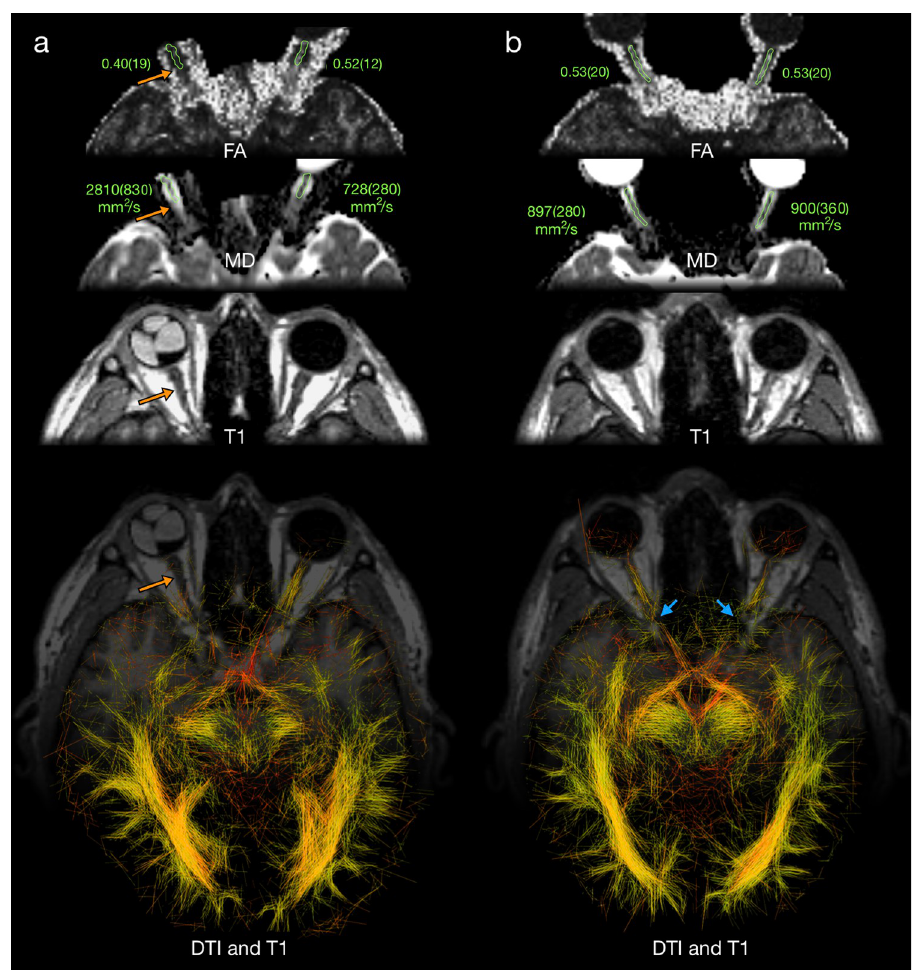
Fig 4. Visual pathway of male subject with right optic nerve atrophy (orange arrows) (a) and for healthy male subject (b) visualized with the new DTI algorithm superimposed on the same T1 image. Optic nerves are also presented on diffusion scalar maps FA and MD, and on morphological T1-weighted images. Actual values of FA and MD measured in a region of interest containing the optic nerve are presented in green. Blue arrows: optic canal and locations of visible discontinuities. Orientation convention: radiological. Values of α , β , γ and σ used in visualization were 250, 1000, 1.2 and 0.2, respectively.